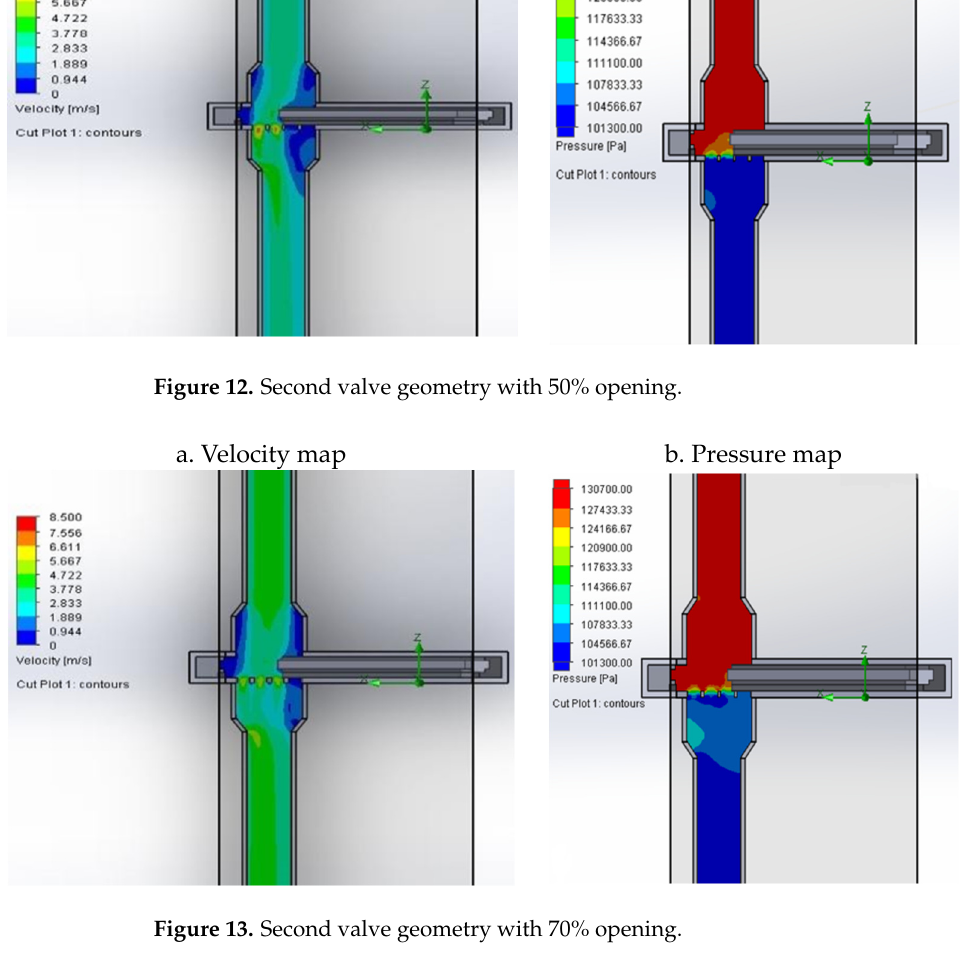
Figure 13. Second valve geometry with 70% opening.